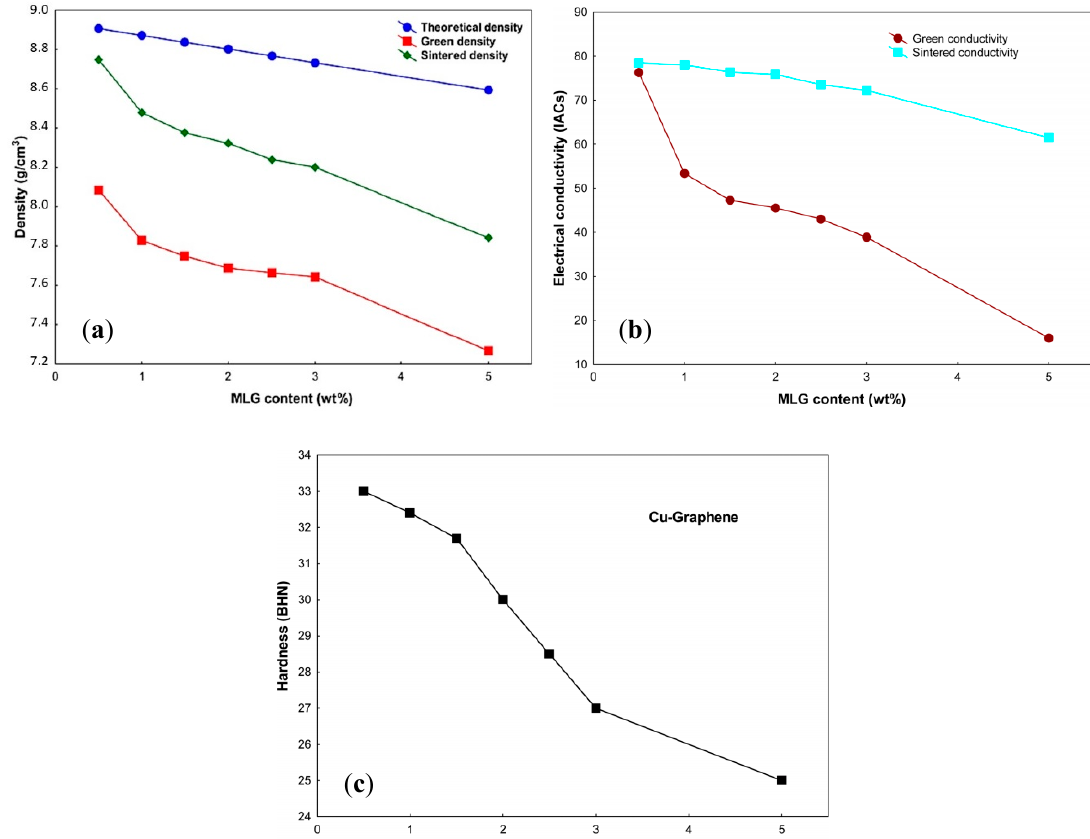
Figure 19. The effect of multilayer graphene (MLG) content on the ( a ) density, ( b ) electrical conductivity and ( c ) hardness of MLG–Cu nanocomposites [188] (Copyright Springer Nature, 2015, Metals and Materials International).